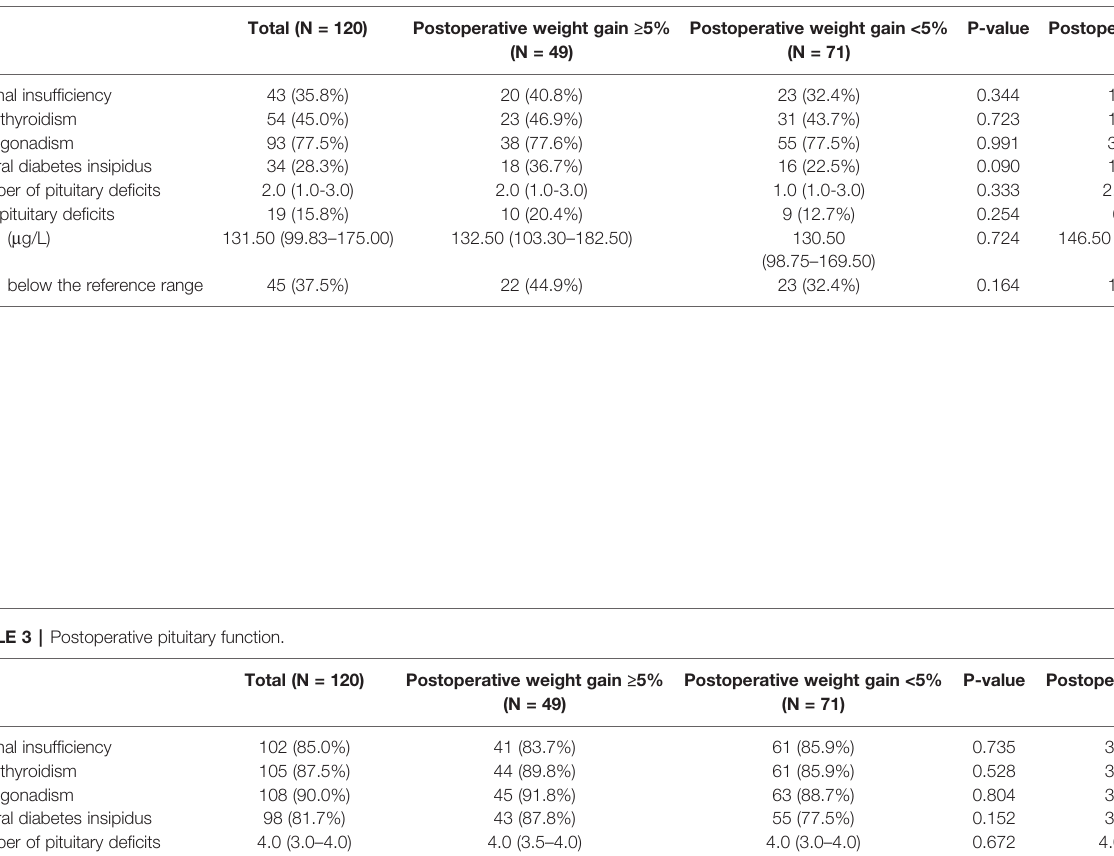
TABLE 2 | Preoperative pituitary function.